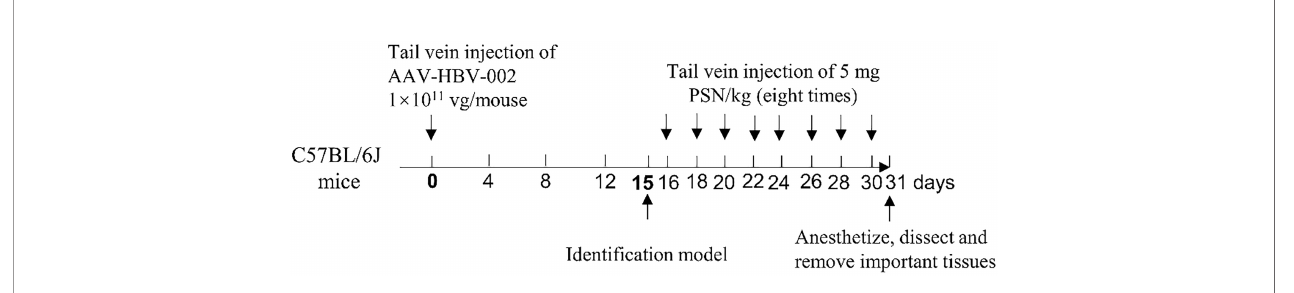
FIGURE 2 | Schematic diagram of mouse modelling and PSN